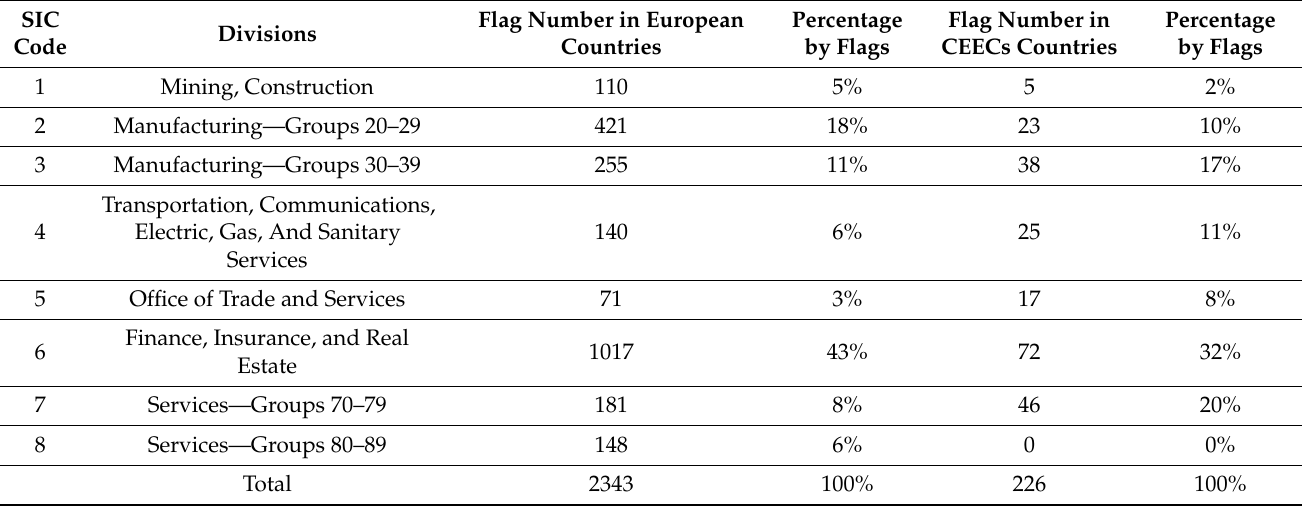
Table 5. Distribution of flags by